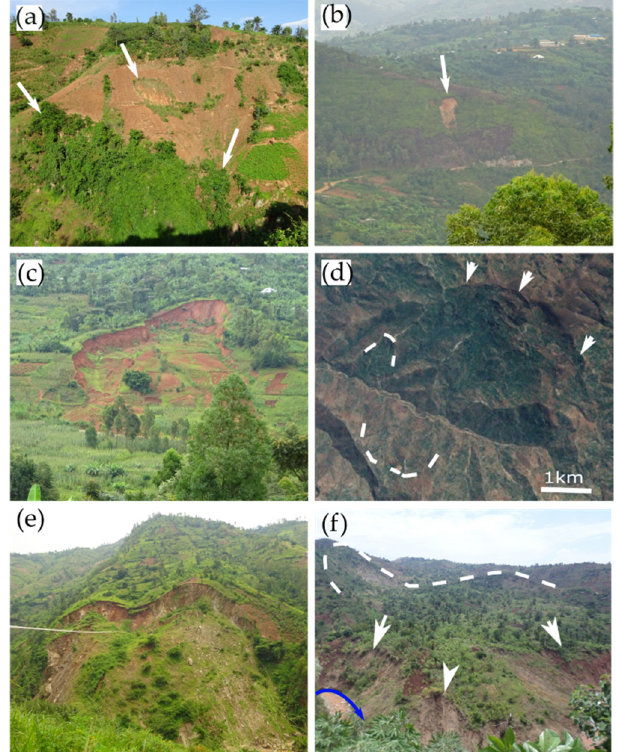
Figure 4. Examples of landslides of the inventory. ( a ) Cluster of rainfall-triggered shallow debris slides and avalanches in agricultural crops (headscarps located with white arrows). Photo taken in January 2019 ( − 3.382°, 29.369°). ( b ) Shallow planar slide above a road. Photo taken in January 2019 ( − 3.355°, 29.492°). ( c ) Recent rotational slide in regolith overlying gneiss in the relict landscape. Photo taken in January 2019 ( − 3.381°, 29.494°). ( d ) Old and very old landslides in the Mugere catchment area (©Google Earth, image from December 2018). White arrows locate the head of a mountain slope deformation ( − 3.477°, 29.419°) while dashed lines delineate the head of two deep-seated landslides. ( e ) Recent slide reactivation that occurred in 2012 in the rift sediments of the Ntahangwa catchment. Photo taken in January 2019 ( − 3.380°, 29.404°). The slide is visible on the historical photograph from the 1950s. ( f ) Active slide—earthflow developed on gneiss with several recent shallow secondary landslides (white arrows) at its toe (that is eroded by the Kanyosha river). Photo taken in August 2016 ( − 3.432, 29.388°).